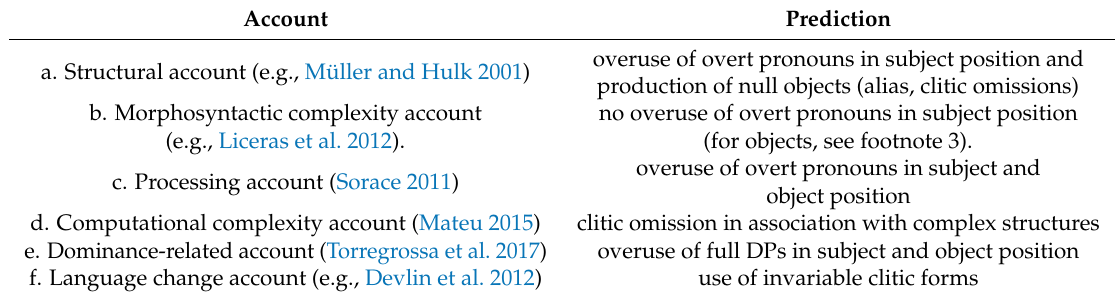
Table 1. Summary of the predictions related to reference production in Italian by German-Italian